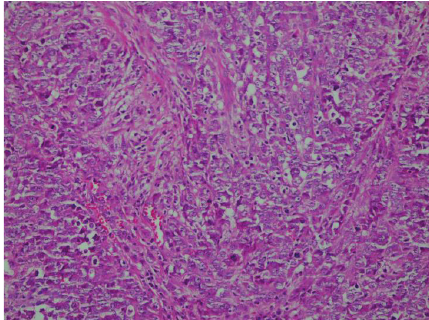
Figure 4: Epithelioid type of malignant mesothelioma formed by malignant epithelioid cells